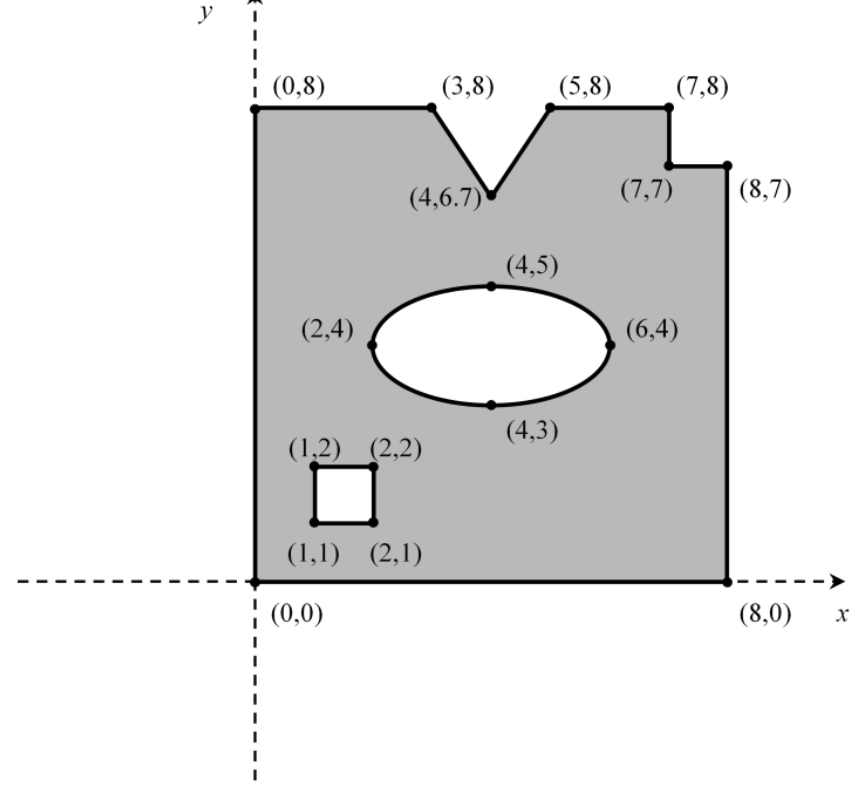
Figure 7. Condition number of stiffness matrix for the 1D constant parameter identification problem.